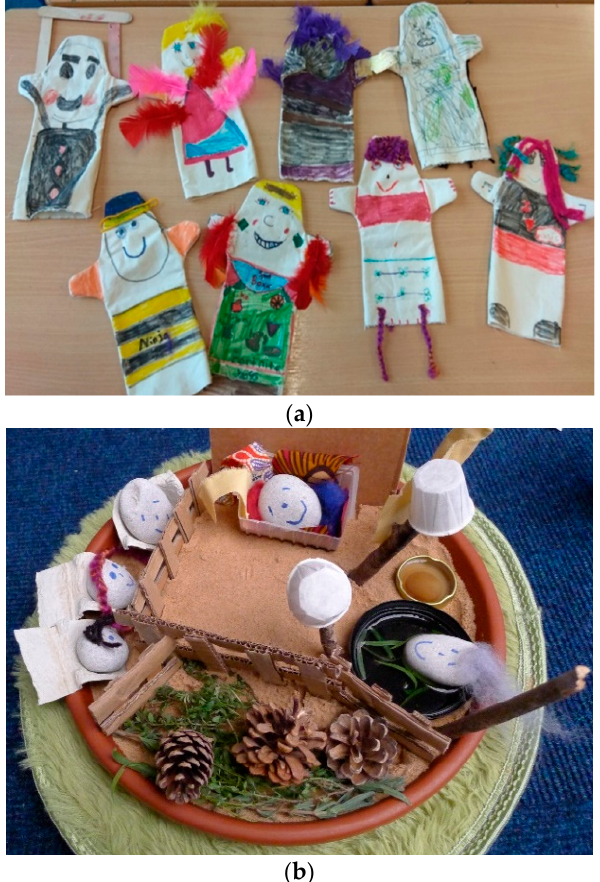
Figure 2. Engagement with the arts and self-expression. ( a ) Puppets—dramatherapy; ( b ) Sand trays—art therapy.